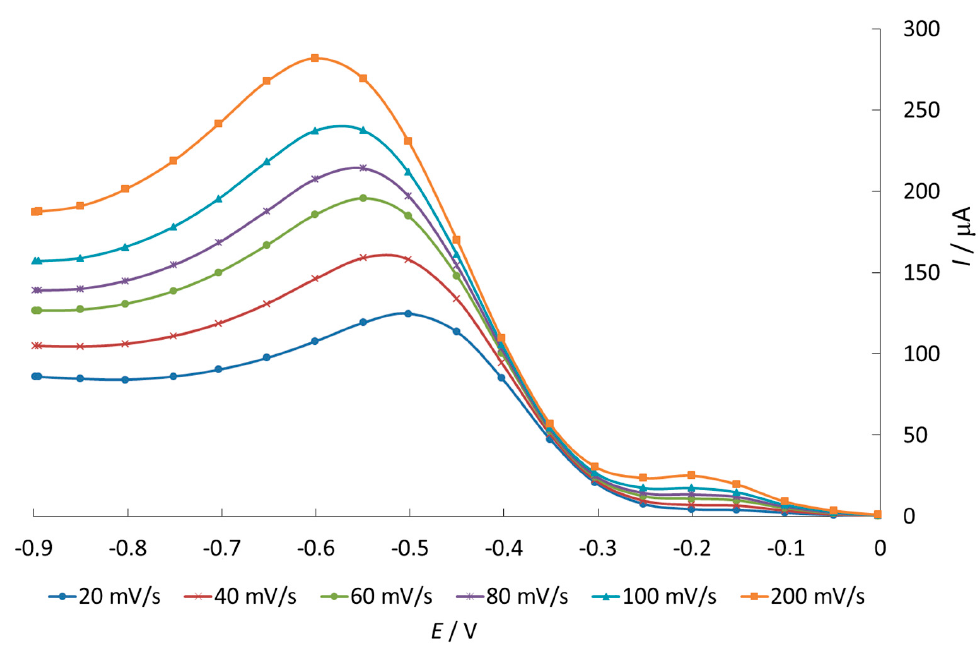
Figure 3. Voltammograms of O 2 electroreduction on a mercury—film electrode versus the potential sweep rate in the presence of 0.1% phenothiazine in 85% ethanol solution.